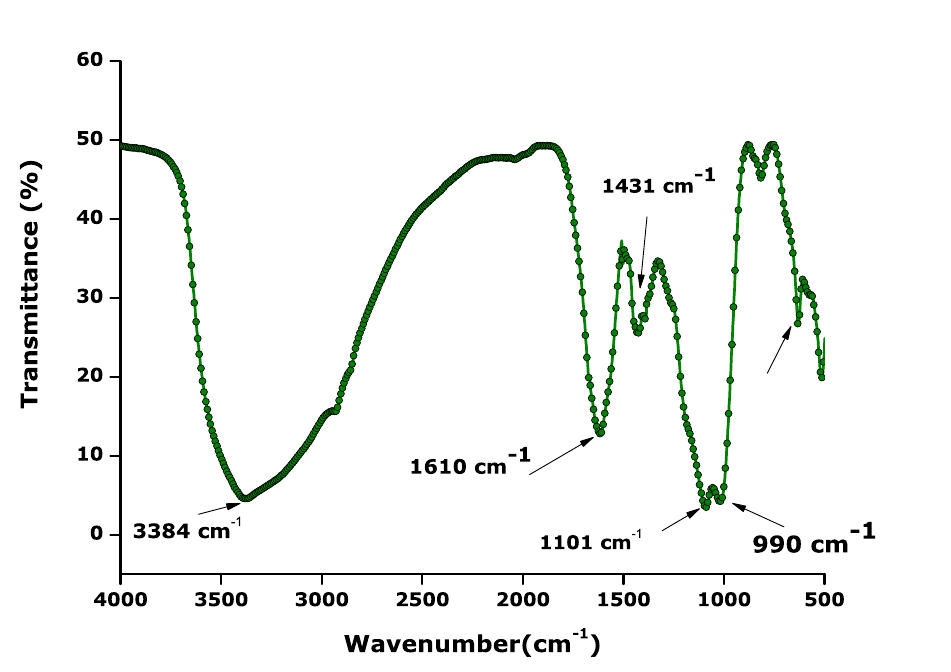
Figure 4. Fourier transform infrared spectra of the prepared hydronium jarosite